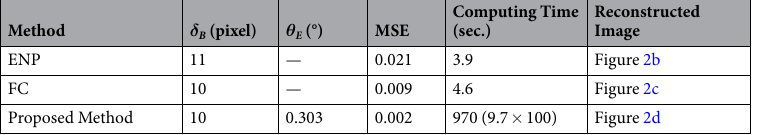
Table 1. Results of applying the ENP, FC, and proposed methods to Phantom 1. The θ E values of the ENP and FC methods are denoted by dashes because these two methods could not correct the projection angle errors.